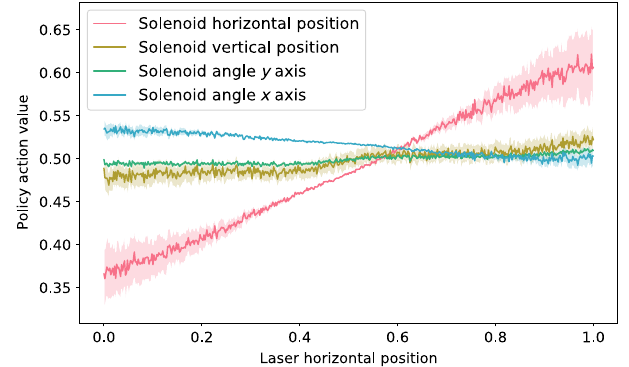
FIG. 10. Random action values ordered by laser horizontal positions; The standard deviation of the input values is σ ¼ 0 . 2 . This plot shows the mean of 500 laser horizontal positions and 1000 repetitions. The variance is plotted semitransparent. The plot shows that with increasing laser horizontal position, also the solenoid horizontal position is increased. The solenoid angle in the y axis is also moved slightly. However, the solenoid vertical position and solenoid angle x axis are almost not